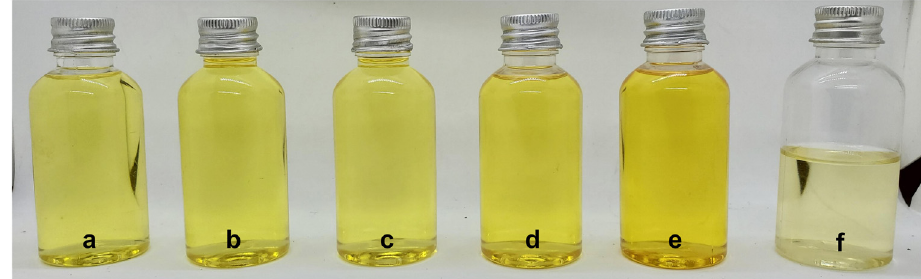
Figure 1: Color change of LEO at di ff erent time points: ( a ) initial LEO; ( b ) after 1 week at room temperature; ( c ) after 1 month at room temperature; ( d ) after 1 week at 45°C; ( e ) after 1 month at 45°C; and ( f ) redistilled